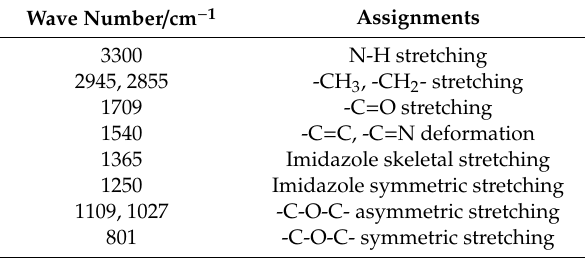
Figure 1. FTIR spectrum of IWPU. Table 2. FTIR peak positions of IWPU.